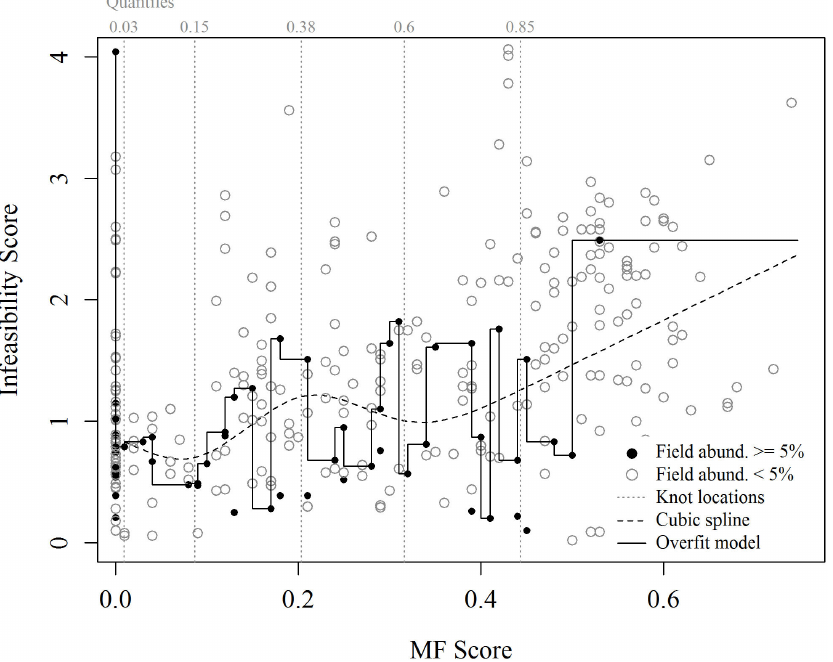
Figure 5. Possible thresholds for MTMF post-processing image classification attainable with an iterative “drawing” approach. Compare with Figure